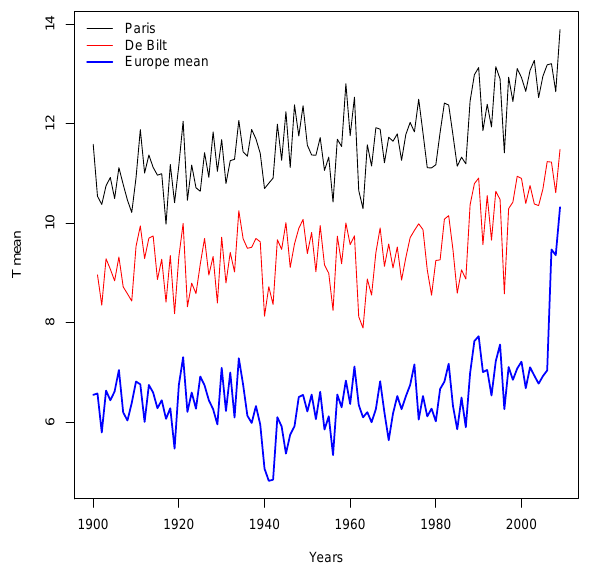
Fig. 1. Variations of the annual averages of daily mean temperature in Paris, De Bilt and a European mean, between 1900 and 2009. The data are taken from the ECA&D database (Klein-Tank et al., 2002).